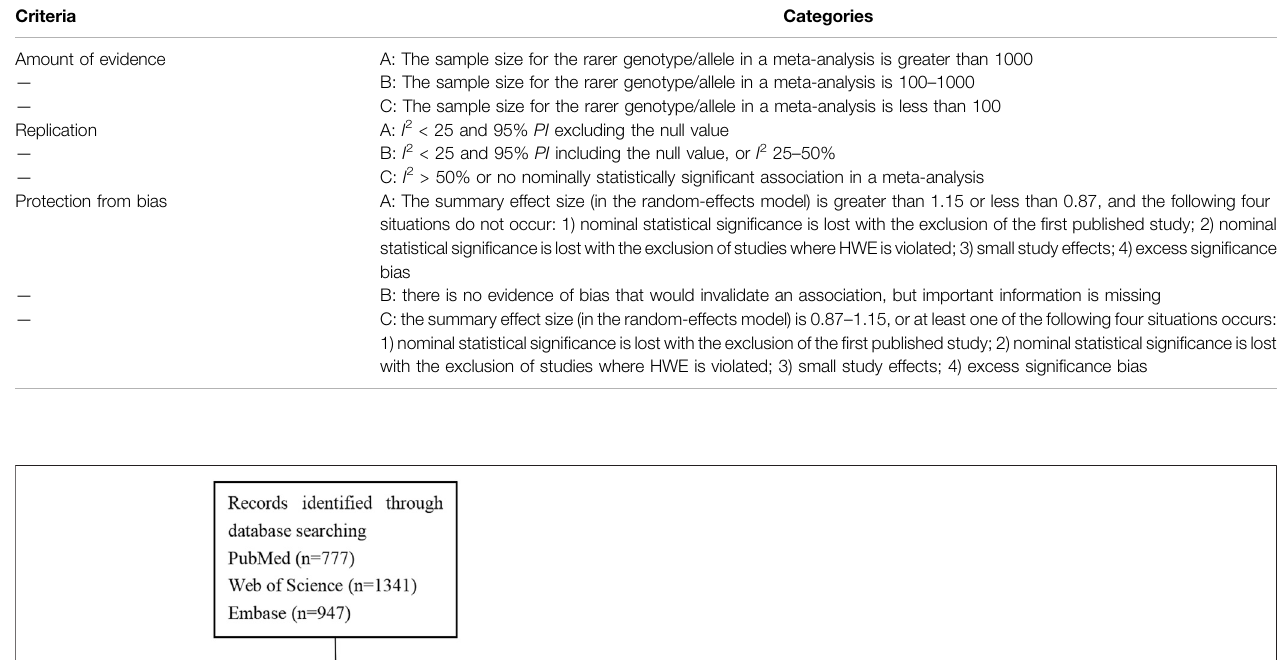
TABLE 1 | Criteria for evaluation of epidemiological credibility.